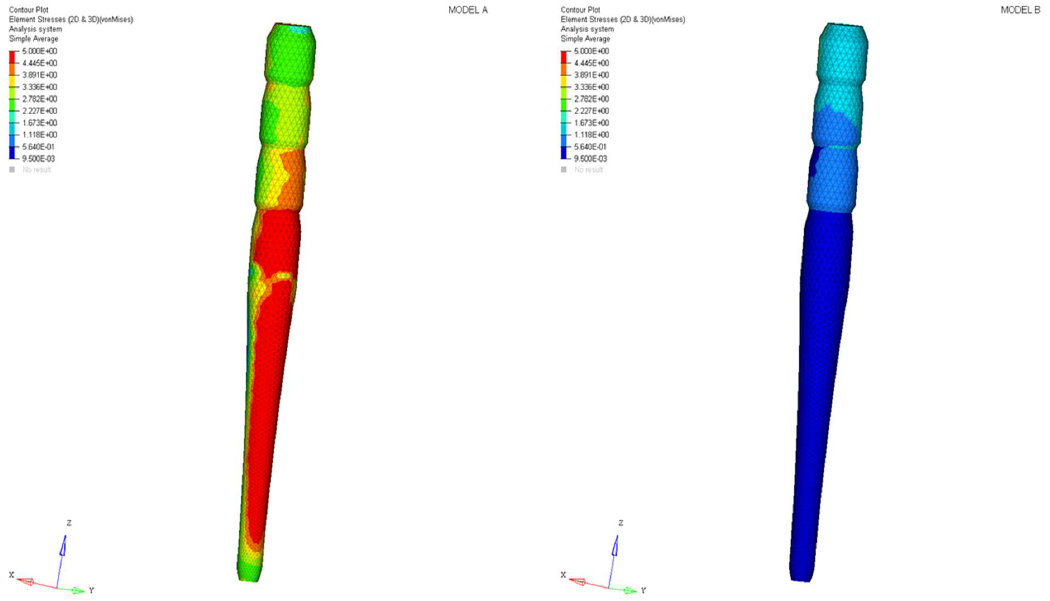
Figure 9. von Mises stress distribution (MPa) at the interface between the post and surrounding structures.